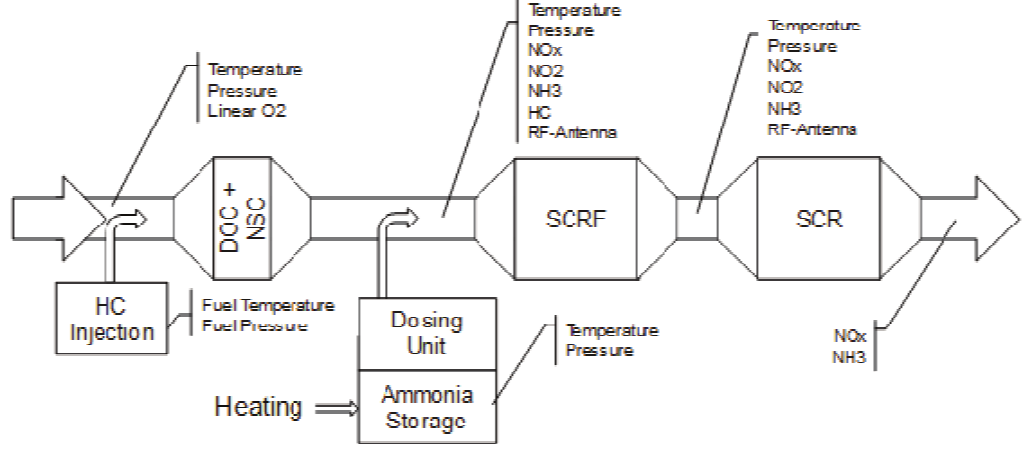
Fig. 2. Future diesel exhaust system example